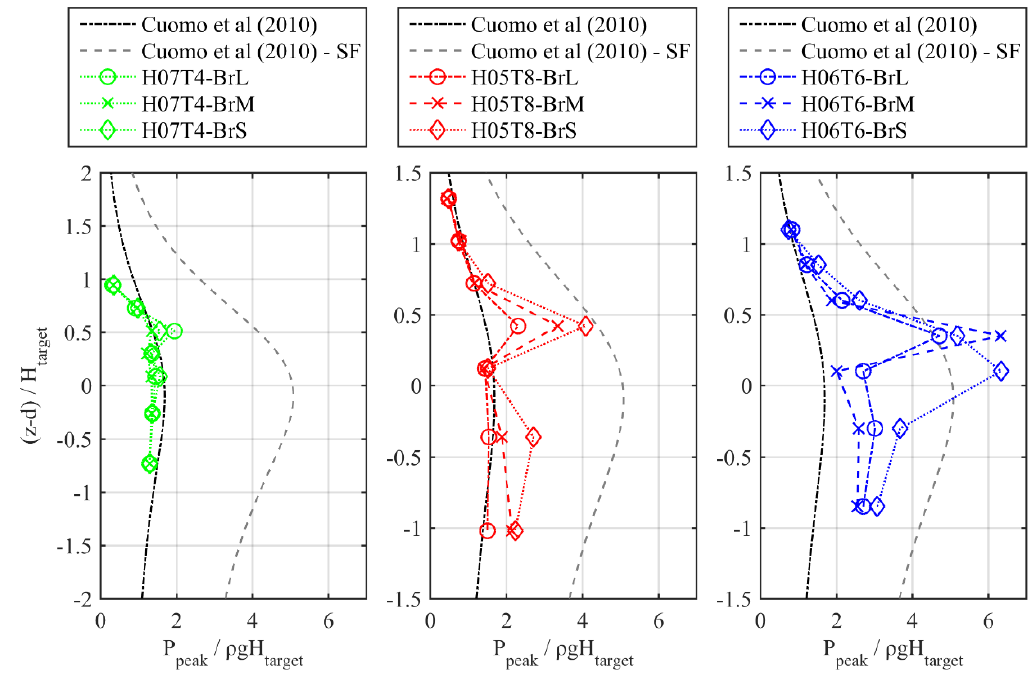
Figure 7. Mean peak pressures at each measuring location for pulsating conditions. Left: H07T4; middle: H05T8; right: H06T6.